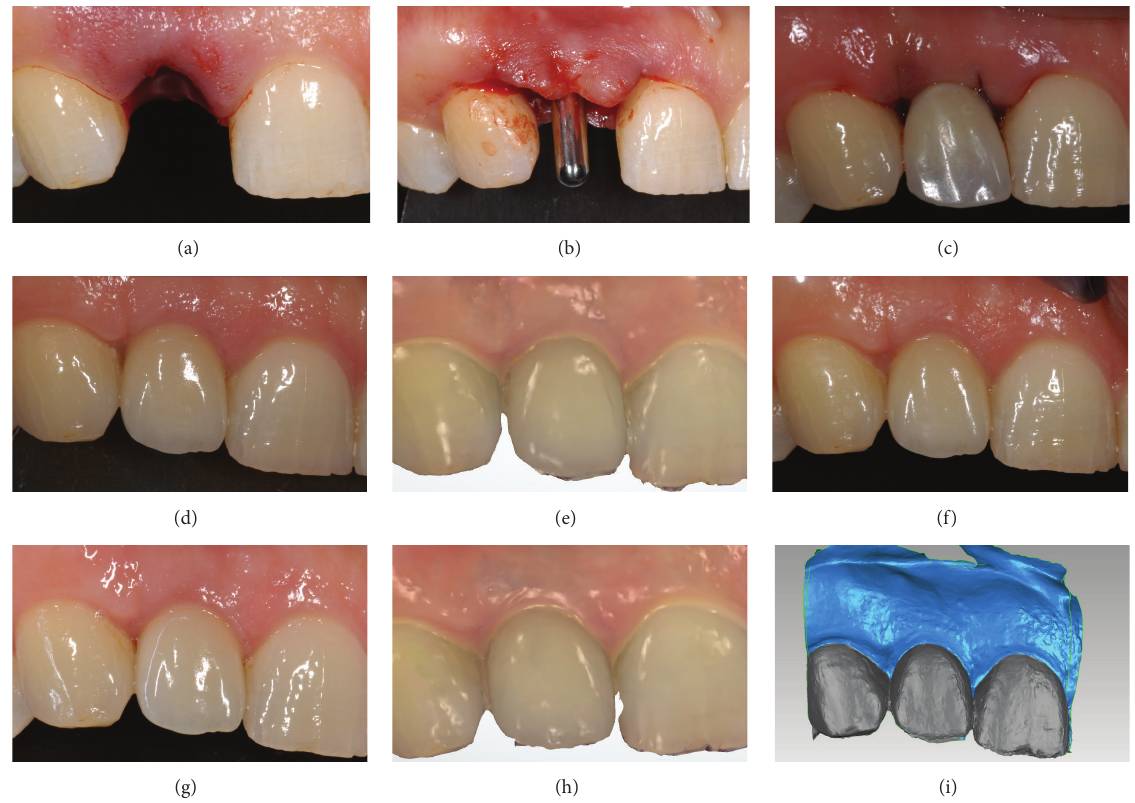
Figure 1: Immediate implant placement in postextraction socket ( test group) of an adult female patient (34 years old): (a) the socket immediately after extraction; (b) the implant (Anyridge, Megagen, Gyeongbuk, South Korea) was placed in the fresh extraction socket; (c) the implant was immediately loaded with a provisional resin crown; (d) three months later, the final metal-ceramic crown was delivered to the patient; (e) first scan (S1) of the peri-implant soft tissues with a powerful intraoral scanner (Trios (cid:2) , 3-Shape, Copenhagen, Denmark), at the delivery of the final crown; (f) 1-year clinical control; (g) 2-year clinical control; (h) second scan (S2) of the peri-implant soft tissues 2 years after the delivery of the final crown; (i) overlapping of digital images (S2 over S1) in powerful reverse-engineering software (Geomagic Studio 2012 (cid:2) , Geomagic, Morrisville, NC,